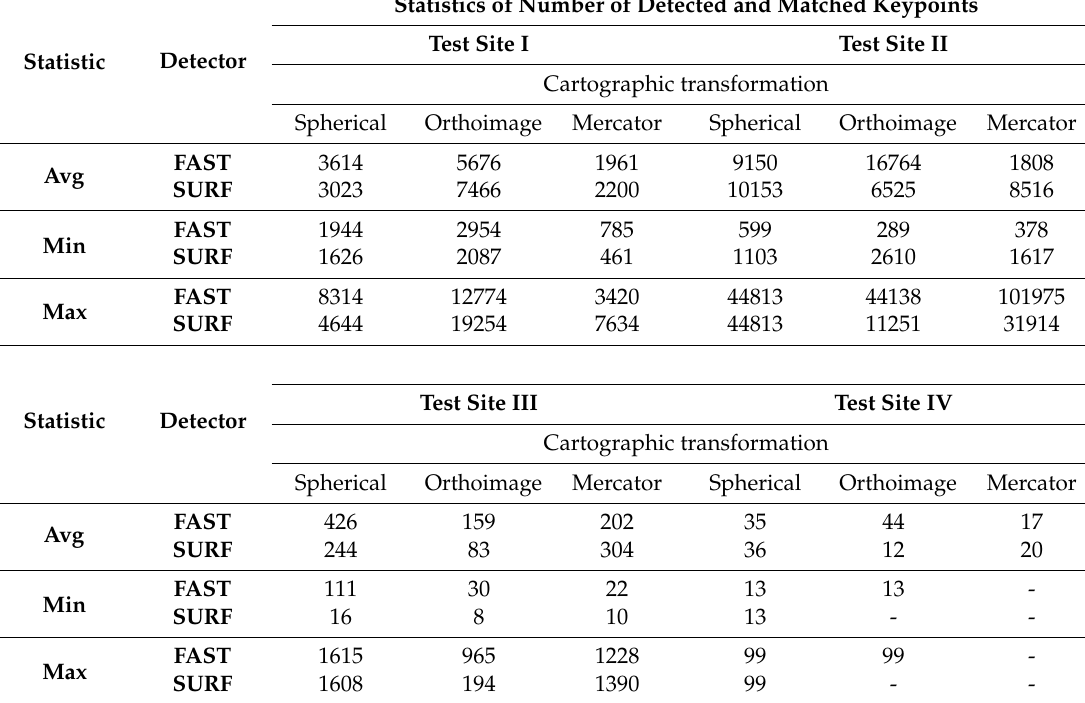
Table 3. Statistics of number of detected and matched keypoints for particular projections of point clouds for all test sites (both